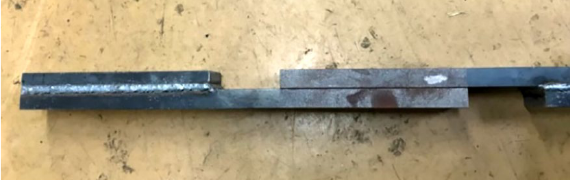
Figure 7. Specimens overlapped of two steel coupons